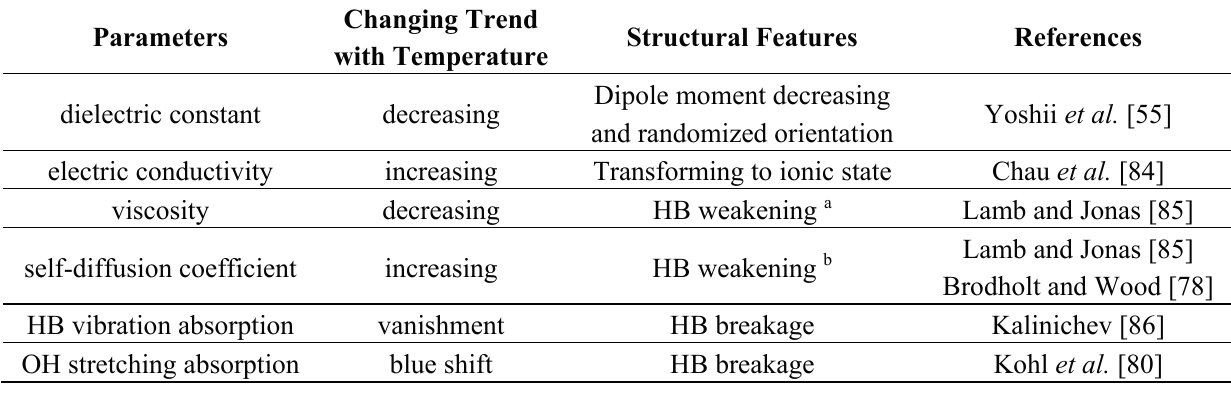
Table 2. Property changes and the corresponding presumption on structural features of